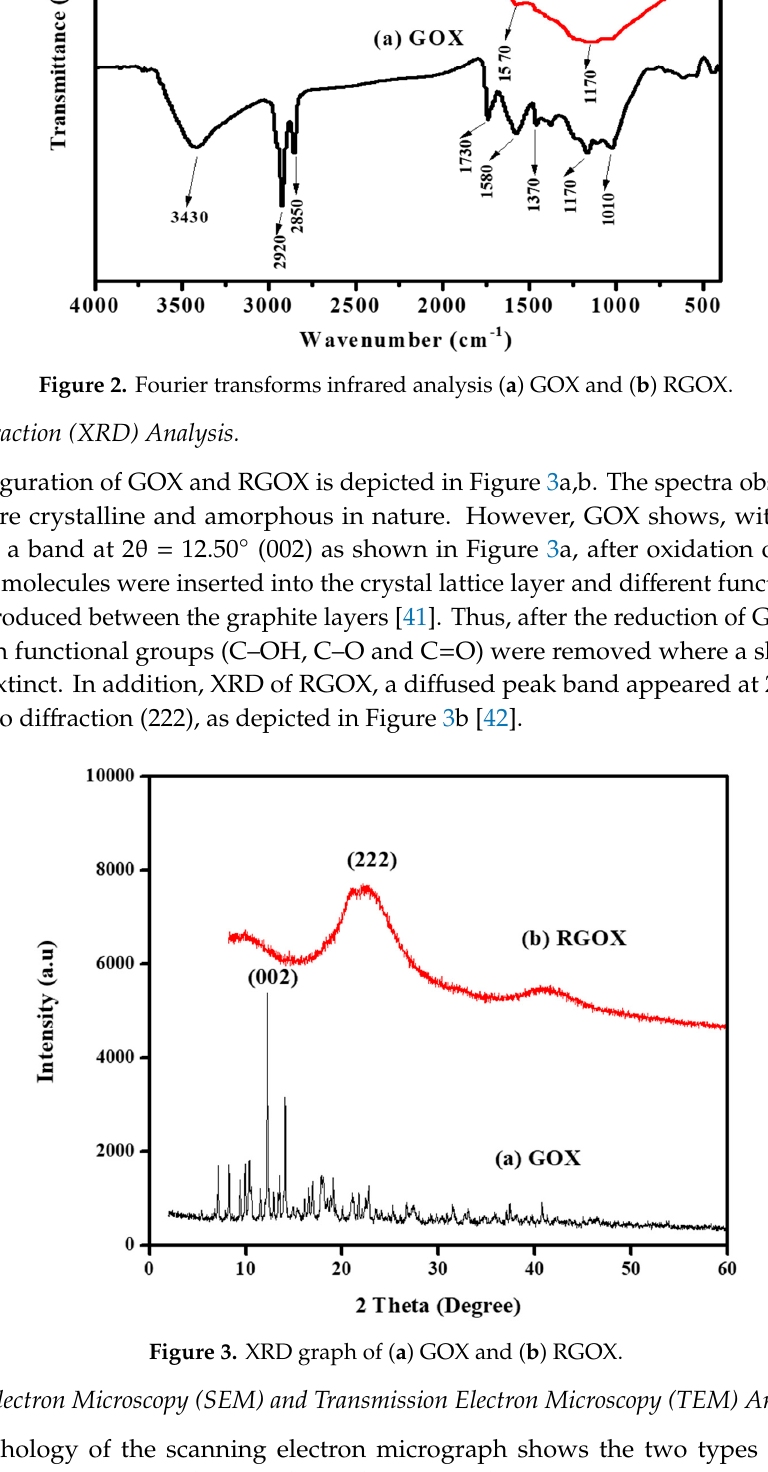
Figure 4. Scanning electron microscopy images at different magnifications ( a ) GOX at 10 K, ( b ) GOX at 30 K, ( c ) RGOX at 3 K and ( d ) RGOX at 30 K.